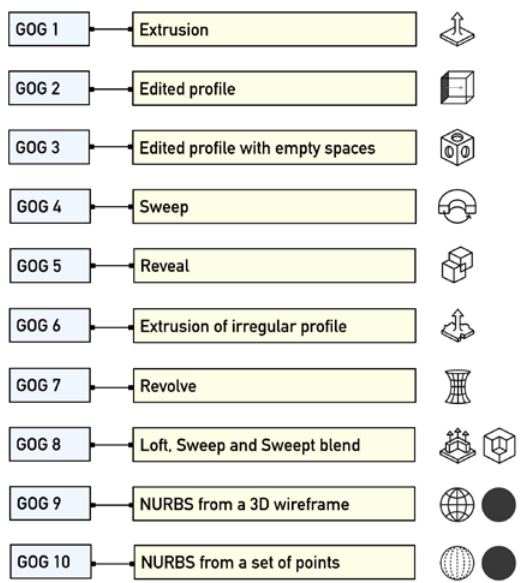
Figure 10. Distance between point clouds and the model of rib vault (overlapped)